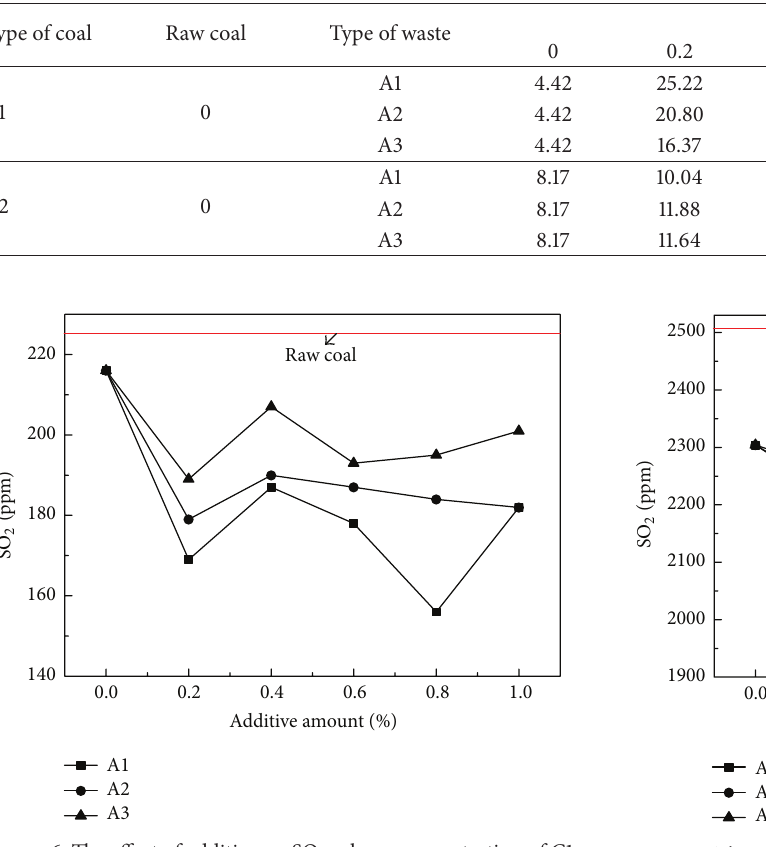
Figure 6: The effect of additive on SO 2 release concentration of C1. Figure 7: The effect of additive on SO 2 release concentration of